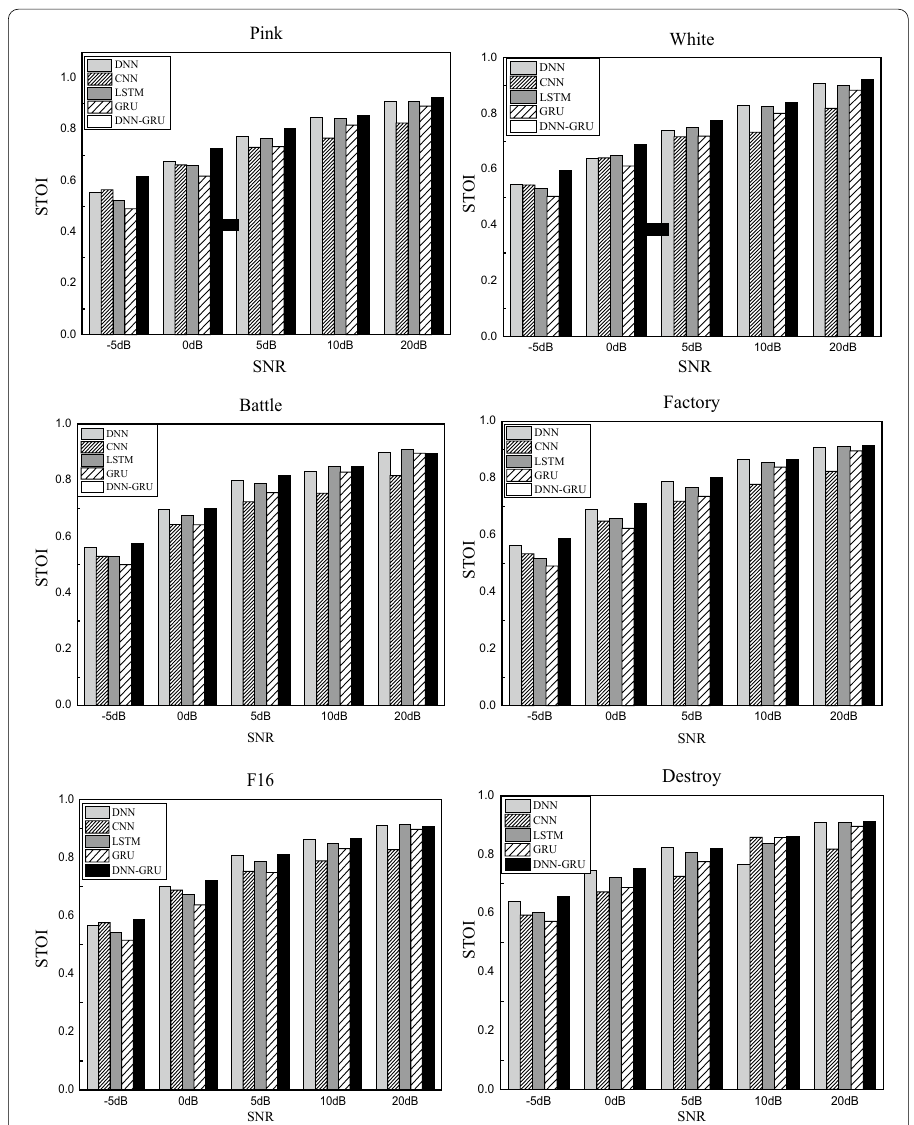
Fig. 8 The STOI results at different